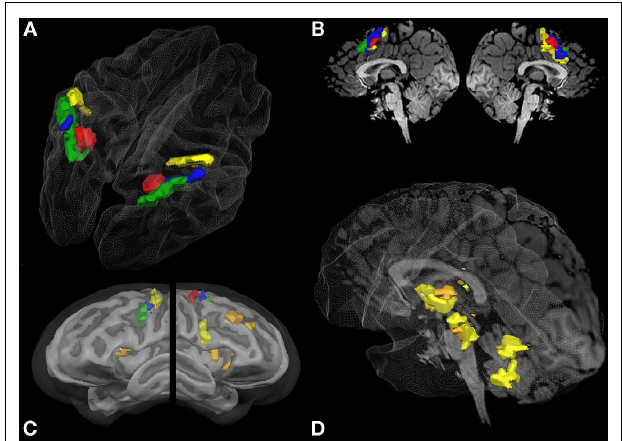
FIGURE 4 | Overlapping regions between specific numerical and non-numerical tasks using inclusion and exclusion analyses: conjunction of all six tasks (red); areas commonly activated in the visually guided saccades task and the visually guided finger task in conjunction with both addition tasks but not the two magnitude comparison tasks (blue); areas exclusively activated during the saccades task but not the finger task in conjunction with both addition tasks but not the magnitude comparison tasks (green); areas activated exclusively during the finger task in conjunction with both addition tasks (orange); and areas exclusively activated during the finger task and the non-symbolic addition task (yellow). All group activations are projected onto aTalairach child template [ (A) parietal activation cluster; (C) lateral frontal activation clusters; (D) subcortical activation clusters] or a single child brain inTalairach space [ (B) medial frontal activation clusters; (D) subcortical activation clusters] and are significant at a cluster-threshold corrected p -value of 0.05.